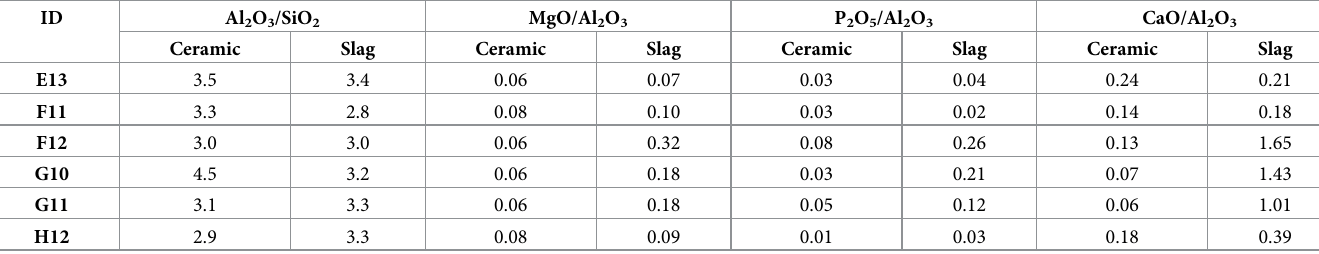
Table 6. Ratios between different elements of the ceramic and slag bulk compositions of all samples.